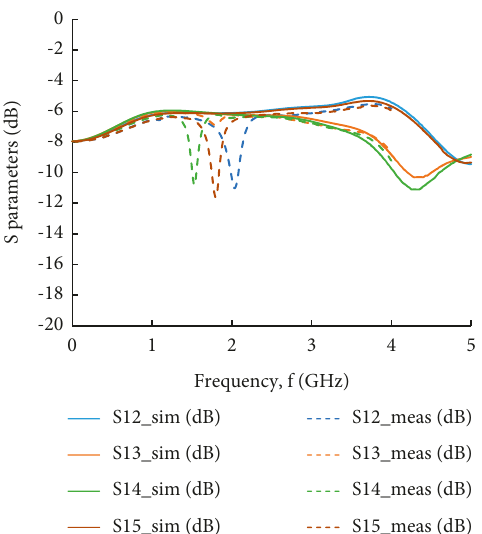
Figure 21: Simulation (dashed lines) and measurement (solid lines) magnitude of S 12 , S 13 , S 14 , S 15 , of the Wilkinson